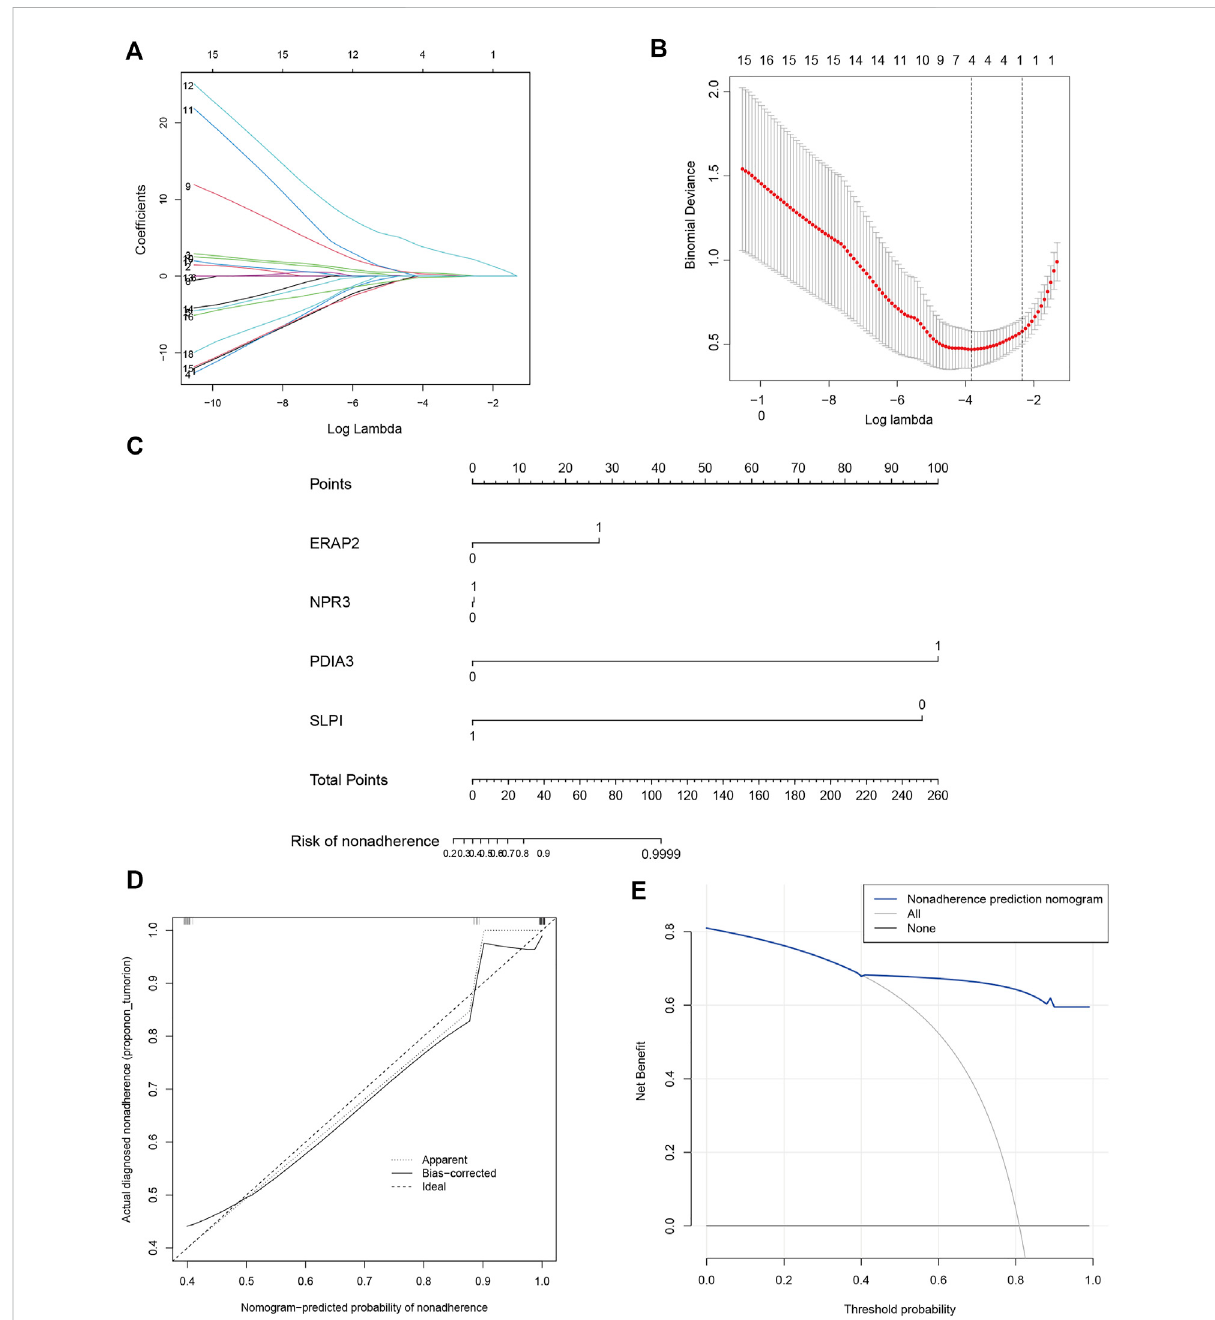
FIGURE 3 Diagnostic model based on mitochondrial dysfunction-related genes. (A) Diagnostic model construction using a least absolute shrinkage and selection operator (LASSO) Cox regression model. (B) Coef fi cient distribution plots to select the optimum lambda value. (C) Plot of diagnostic